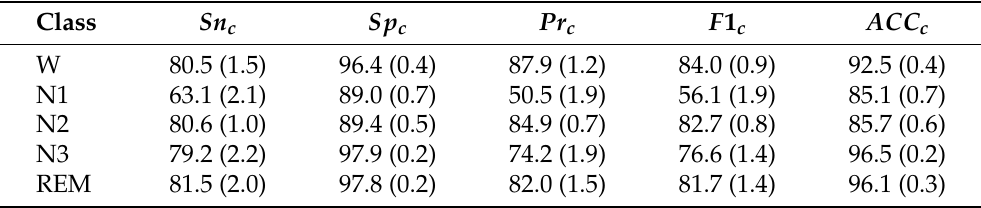
Table 7. 20-fold per-class cross validation performance obtained with oversampled CWT-TF training data applied on C4-M1 and using CNN-RNN transfer learning network. Results are reported as the mean (std) across the 20-fold